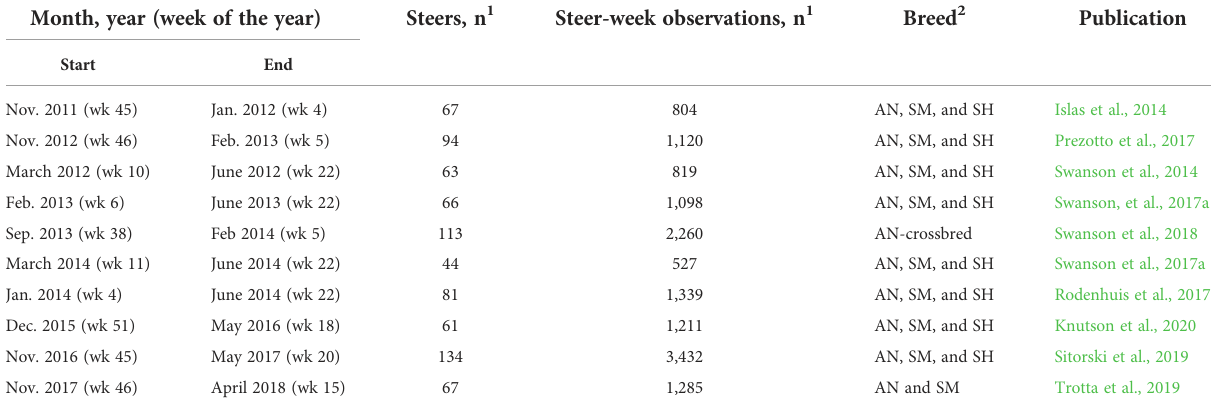
TABLE 1 Experiments used in this study.